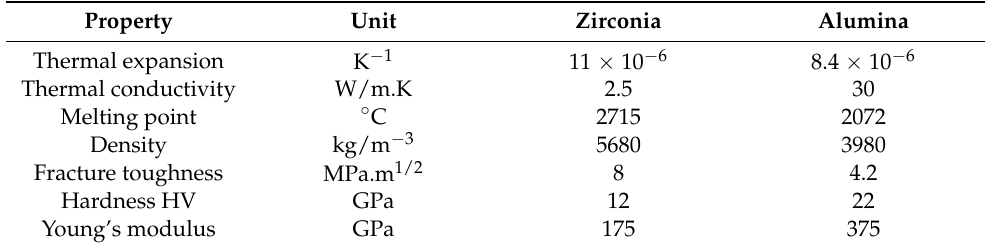
Table 1. Physical and mechanical properties of zirconia and